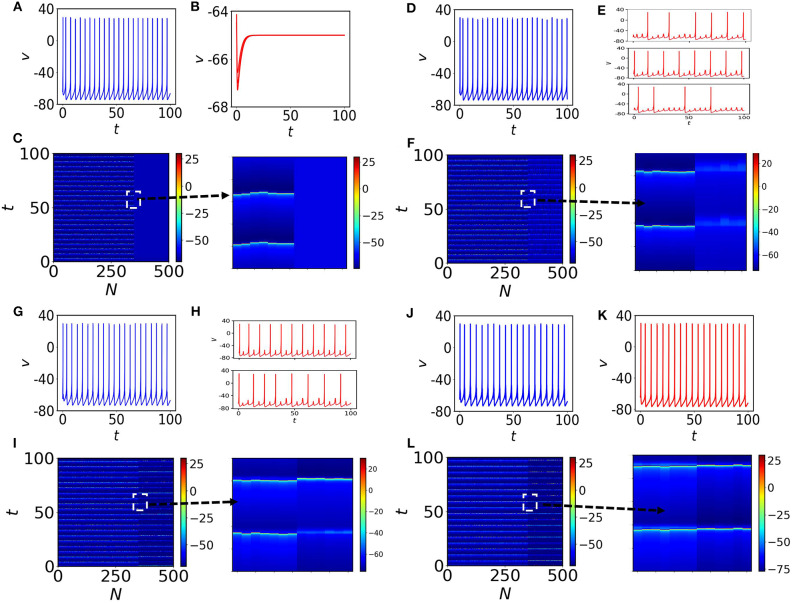
Membrane potential v and spatiotemporal plots. (A) One self-oscillatory spiking neuron in the absence of coupling (K = 0) and a time-series of a quiescent node is shown in (B). (C) The spatiotemporal plot for all neurons in the random network. The first 350 nodes are self-oscillatory. Nodes from 351 to 500 are in steady states (see the 4 zoom-ins). (D,E) The coupling is increased to K = 0.3. There are several types of MMOs observed in the quiescent subpopulation. Three nodes from the quiescent subpopulation are marked and the time series of each node over the course of time is shown in (E). (F) Spatiotemporal plot of all neurons in the random network. The quiescent nodes are desynchronized with each other. (G,H) The coupling is increased to K = 0.4. ISI of spiking nodes are increased and decreased for quiescent nodes. Desynchronized MMOs (shown in (H), where two quiescent nodes have been randomly chosen) are still visible in the quiescent population. (I) Spatiotemporal plot that shows the variation in spikes for all nodes in the random network. (J–L) are for K = 1. The entire population fires (without any MMOs appearing) with almost the same frequencies. Clearly two subpopulation are separately synchronized.